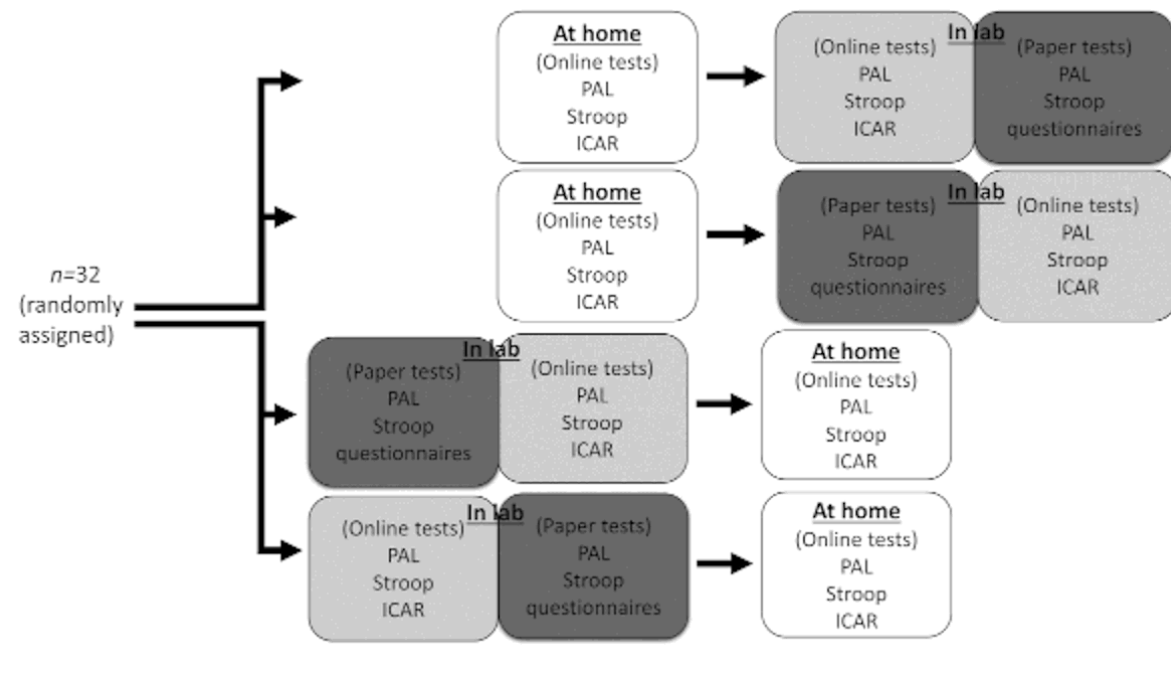
Figure 1. Flowchart of counterbalancing participant assignment to conditions in the experiment. ICAR: International Cognitive Ability Resource; PAL: paired associates